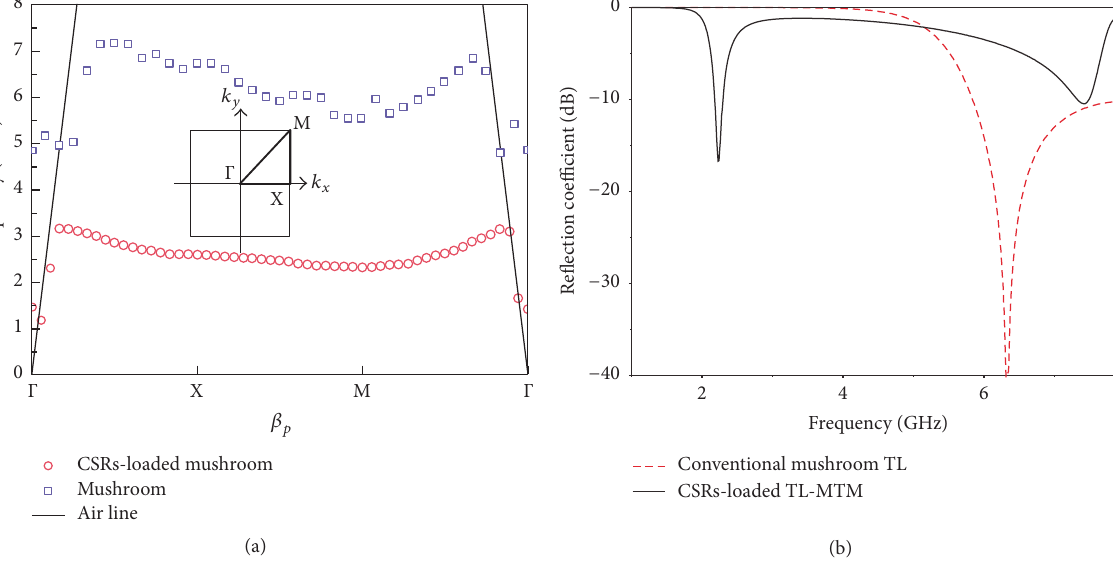
CRLH TL (short for mushroom). In order to design an electrically smaller MTM and make a progress toward homogenized medium [17], a combination of two turns CSRs and mushroom structure is considered and optimized.